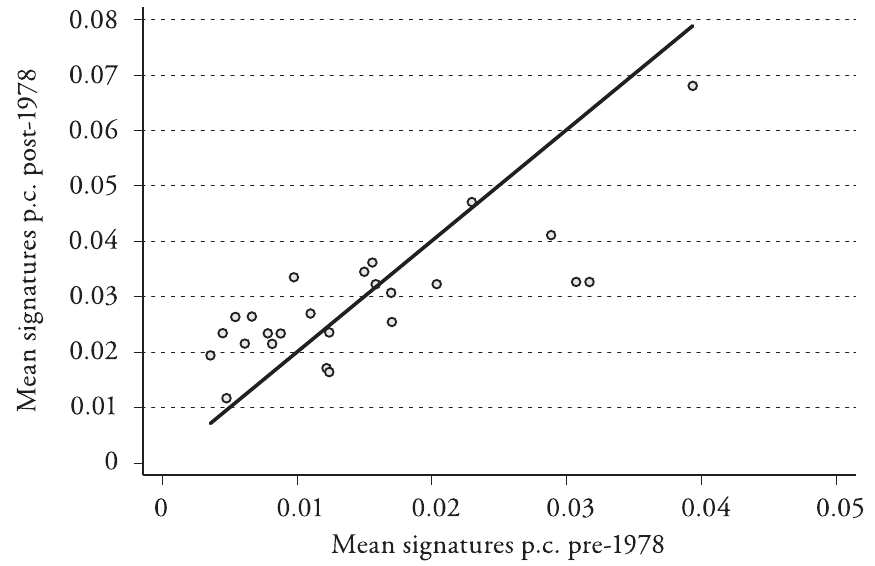
Figure 2: Mean Cantonal Signatures Per